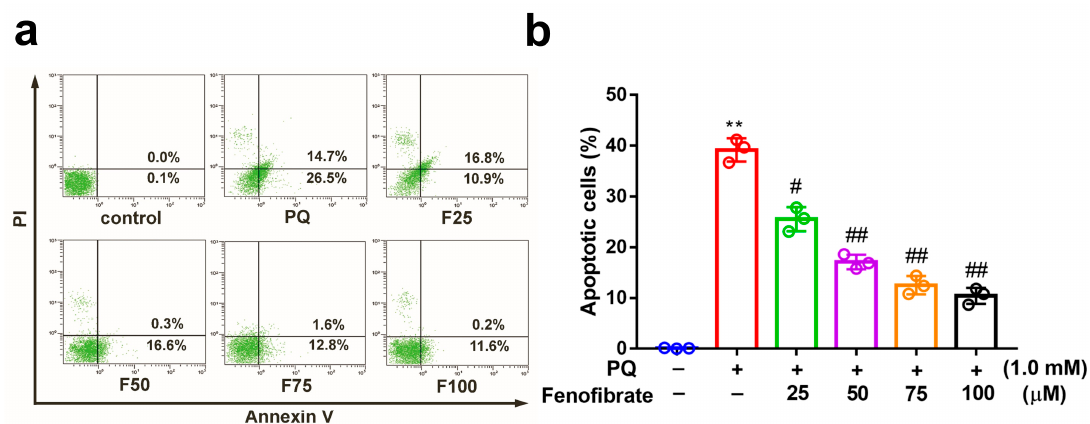
Figure 2. E ff ects of fenofibrate on apoptosis in paraquat (PQ)-stimulated RF / 6A cells assessed by flow cytometry. ( a ) RF / 6A cells were pretreated with di ff erent concentrations of fenofibrate for 1 h and then exposed to 1.0 mM PQ for 24 h. The x -axis and y -axis represent annexin V-FITC and propidium iodide (PI) staining, respectively. PQ: 1.0 mM PQ; F25: 1.0 mM PQ with 25 µ M fenofibrate; F50: 1.0 mM PQ with 50 µ M fenofibrate; F75: 1.0 mM PQ with 75 µ M fenofibrate; F100: 1.0 mM PQ with 100 µ M fenofibrate. ( b ) Percentage of apoptotic cells treated with di ff erent concentrations of fenofibrate. (** p < 0.01 between the control group and 1.0 mM PQ-stimulated group using Mann–Whitney U-test; # p < 0.05, ## p < 0.01 compared to only 1.0 mM PQ-stimulated group using Kruskal–Wallis test with post hoc Dunn’s test; n = 3 in each group).